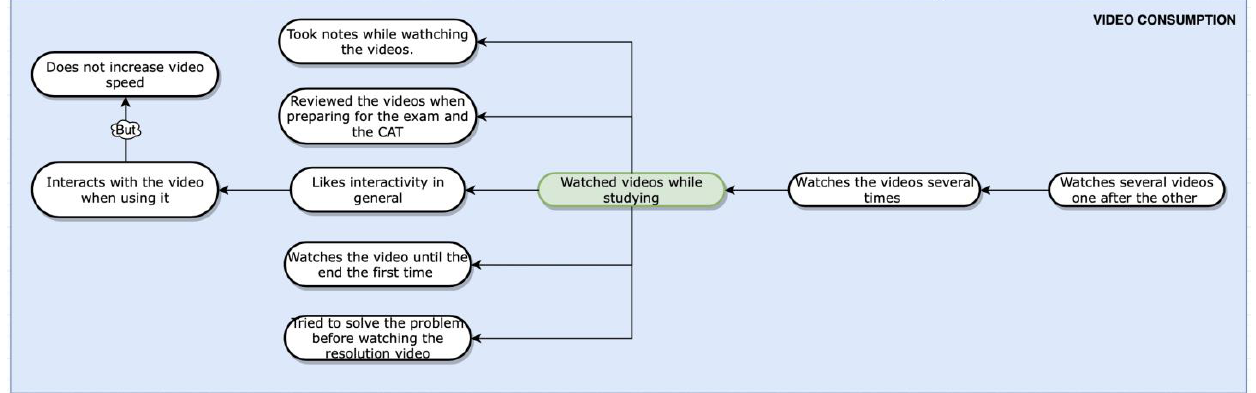
Figure 7. Enlargement of the box “ video consumption. ” .